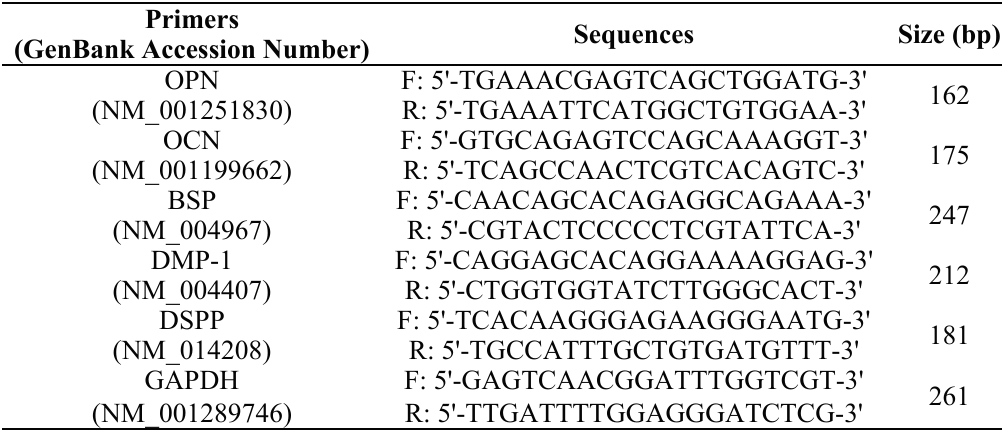
Table 2. Sequences of primers used in real-time